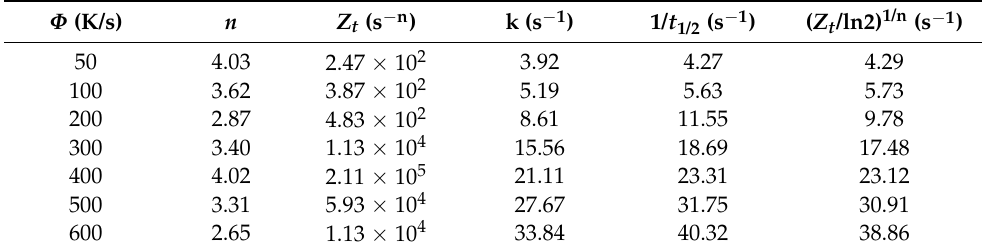
Table 4. Avrami parameters of PEG-PCL at different cooling